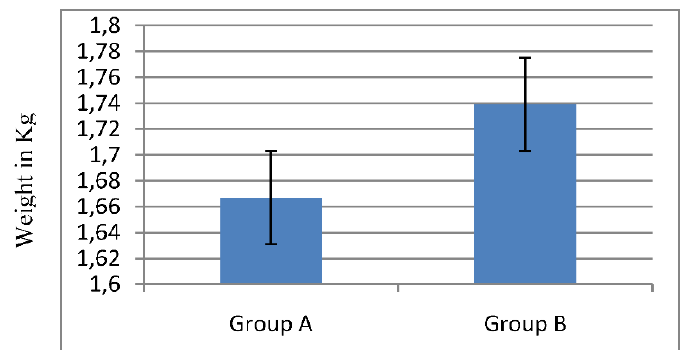
Figure 3. Broiler average growth rate/week. Broilers of group A, fed with ration supplemented with pulp and seeds of pomegranate and avocado by-products, and broilers of group B (control group), fed with basal ration.